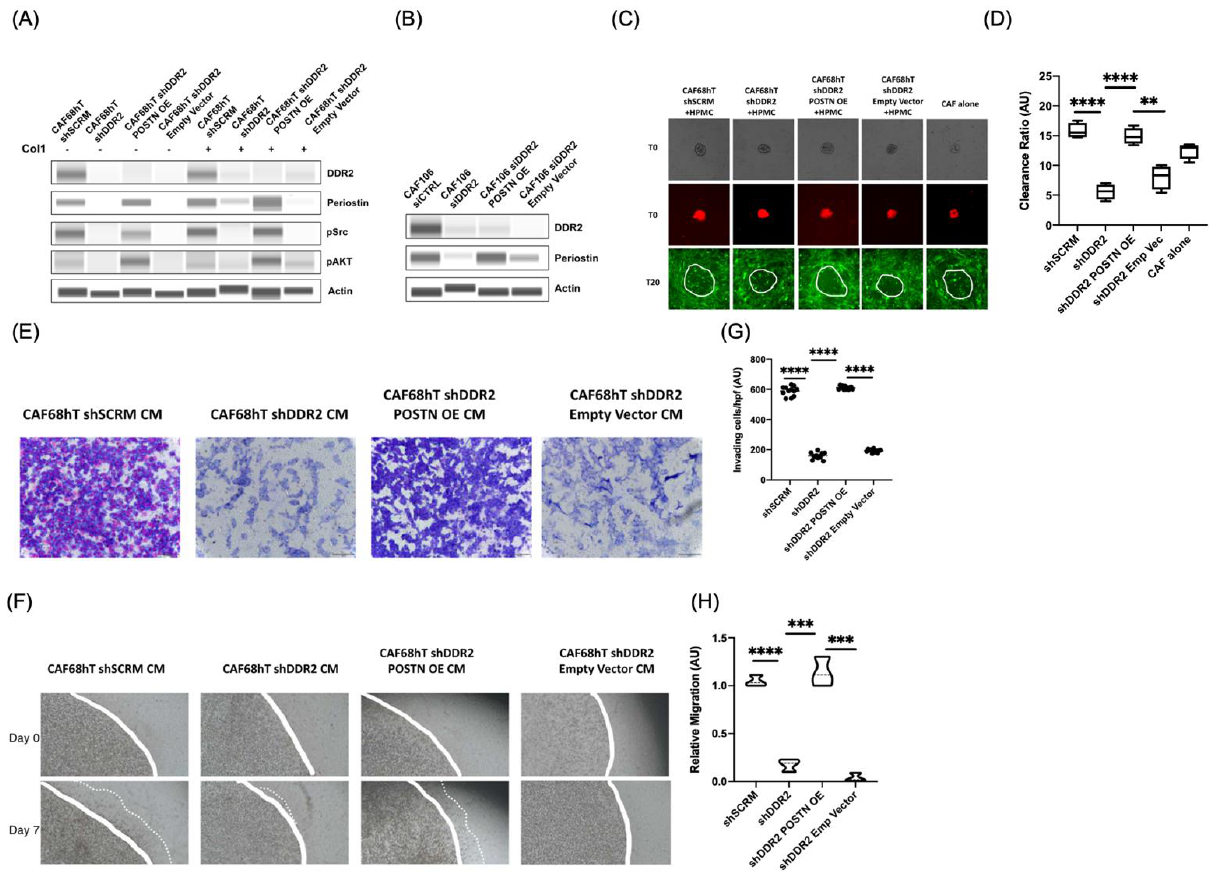
Figure 3. DDR2 and POSTN promote tumor metastasis in cell-based assays. ( A ) Western blot showing increase in pSrc and pAKT in POSTN overexpression in DDR2-depleted CAFs. ( B ) Western blot showing POSTN overexpression in DDR2-depleted CAF106. ( C ) Mesothelial and CAF clearance by tumor cells using DDR2 knockdown and POSTN overexpression CAFs. ( D ) Analysis of assay in ( C ). ( E ) Matrigel transwell tumor invasion assay with ES2 cells using conditioned media from DDR2 knockdown and POSTN overexpression CAFs. ( F ) 3D Collagen tumor cell migration assay using conditioned media from DDR2 knockdown and POSTN overexpression CAFs. ( G ) Analysis of assay in ( E ) and ( H ) Analysis of assay in ( F ). ** p < 0.01, *** p < 0.001, **** p < 0.0001.